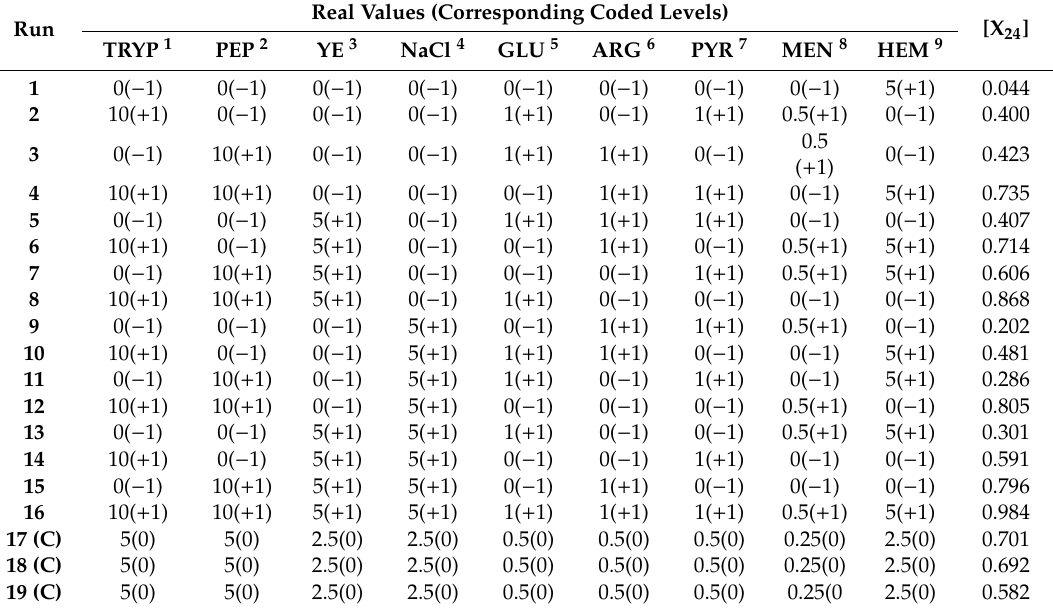
Table 2. Placket–Burman design matrix with real and coded values for C. carboxidivorans syngas fermentation with 1 g / L glucose. Response variables: biomass concentration—[X 24 ] (g d.w.cells / L)—and maximum ethanol production—P EtOH (g /